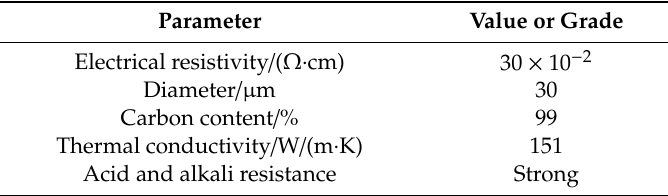
Table 2. Physical properties of graphite powder.